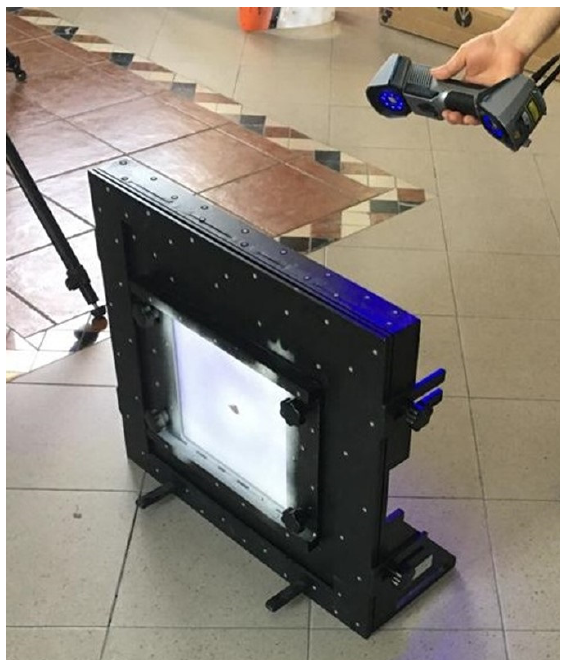
Figure 6. Sample panel during 3D scanning with FreeScan UE7.